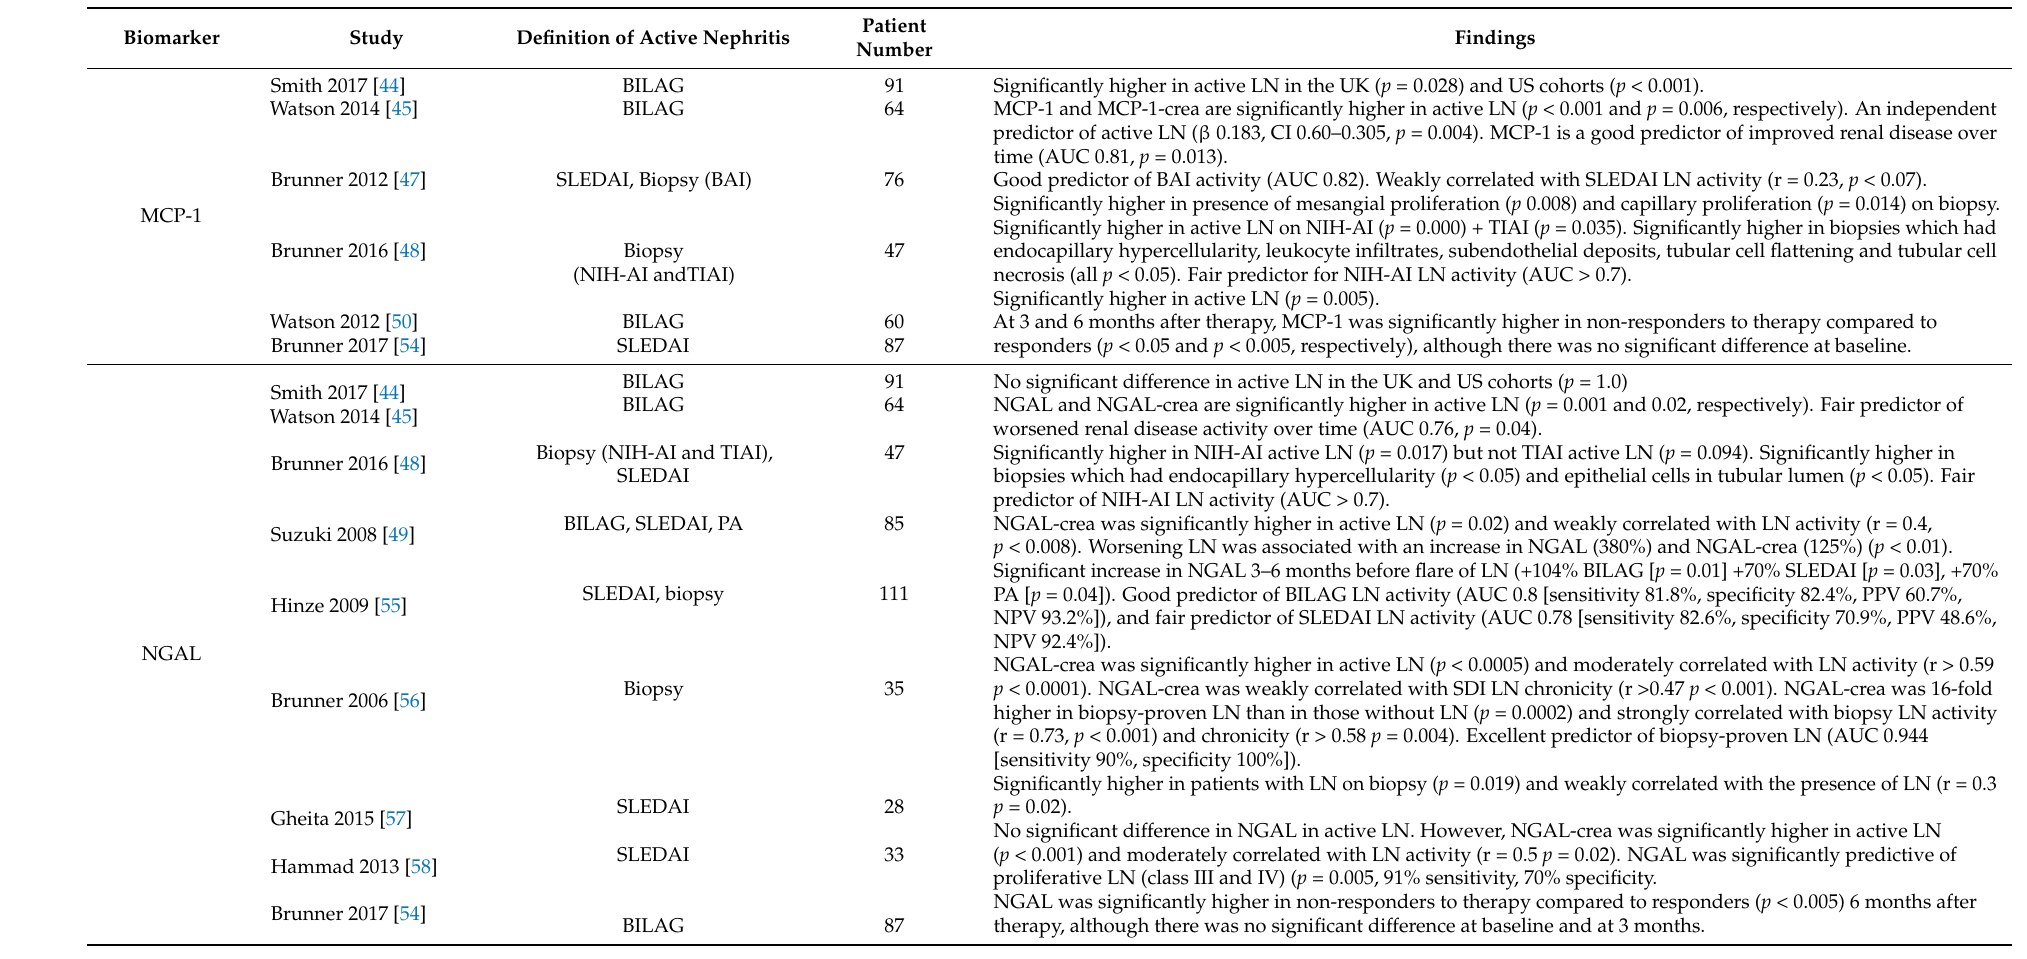
Table 2. Validated novel urinary renal